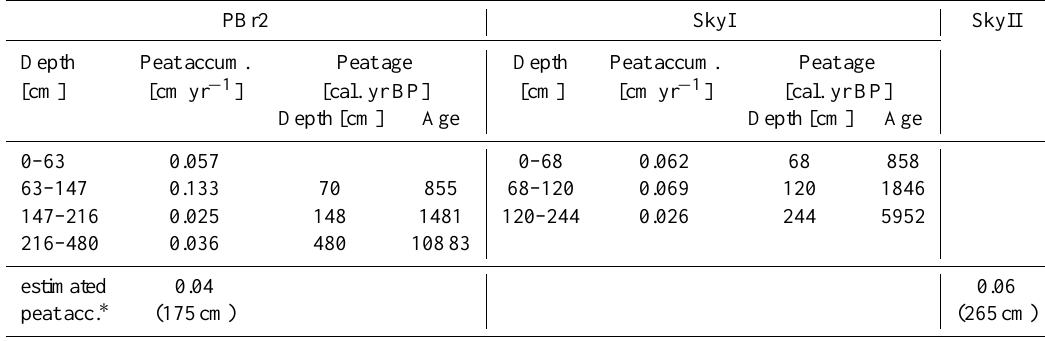
Table 5. Peat accumulation rates for the PBr2 and SkyI bogs from Biester et al. (2003) and peat ages from Kilian et al. (2003) since the beginning of ombrotrophic peat growth. Mean estimated peat accumulation rates determined in this study for PBr2 and SkyII are given at the table